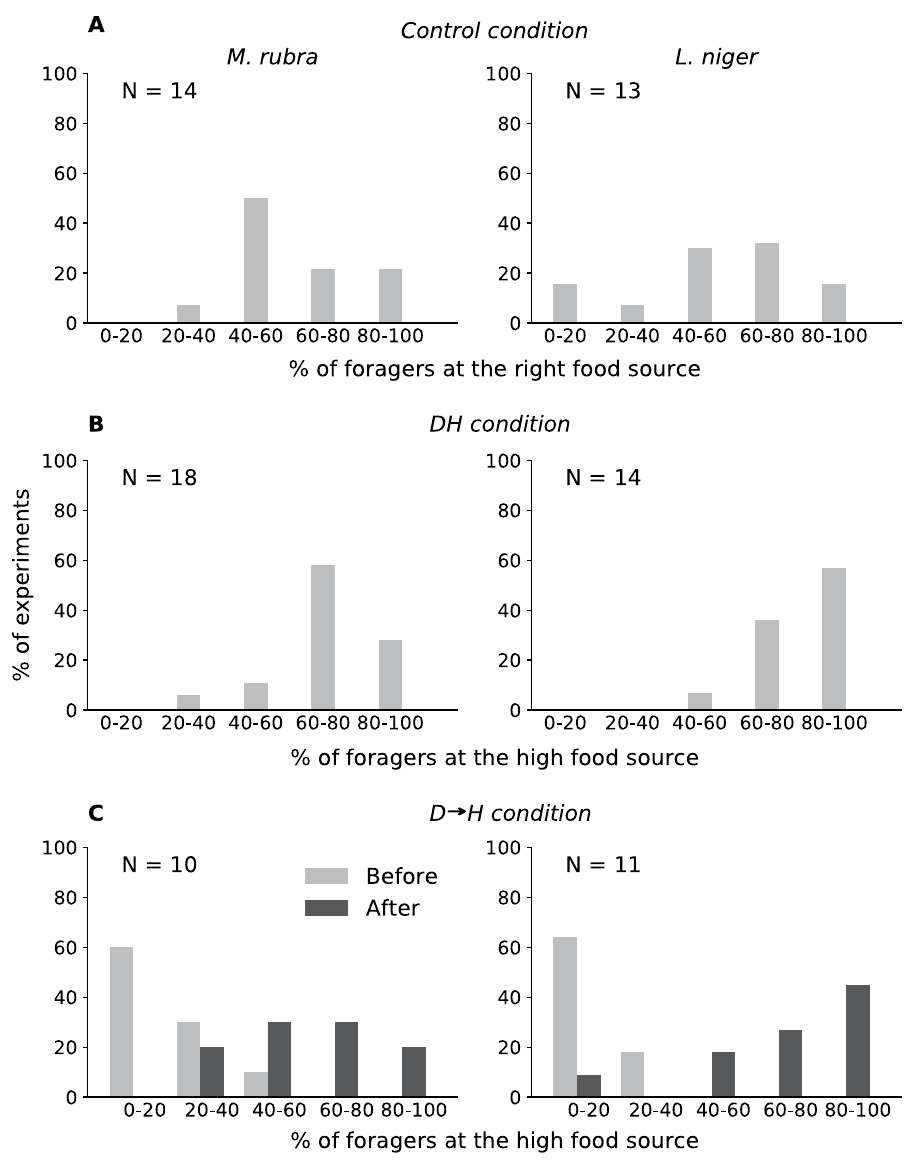
Figure 2. Strength of choice towards a food source. Percentage of experiments against percentage of total foragers present at the high food source for each experimental condition and species. For the D → H condition, as in Table 1, we separated the results into two phases, before and after the introduction of the second food